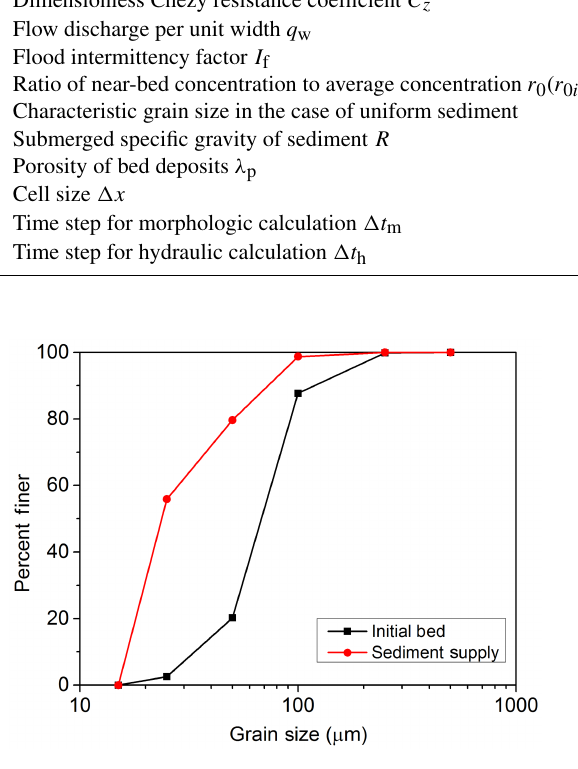
Figure 2. Grain size distributions of both the initial bed and the sed- iment supply in the case of sediment mixtures. For the initial bed, the surface and substrate grain size distributions are the same. The grain size distribution of the initial bed is renormalized based on the field data at the Lijin gauging station. The grain size distribution of the sediment supply equals the grain size distribution of bed mate- rial load at equilibrium. Grain sizes in the range of wash load have been removed from both